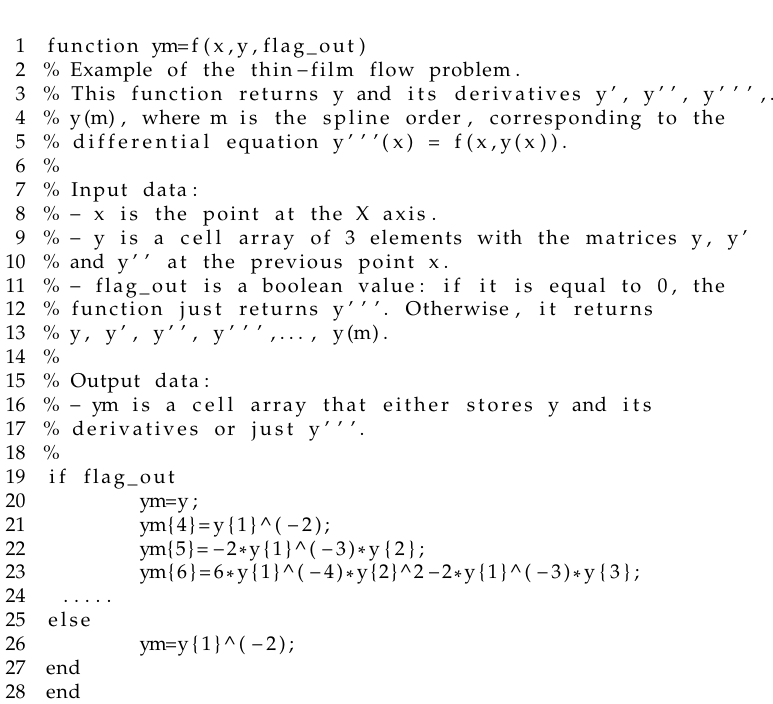
Figure 2 reproduces the MATLAB function f for the thin-film flow of problem (33). being the spline order.